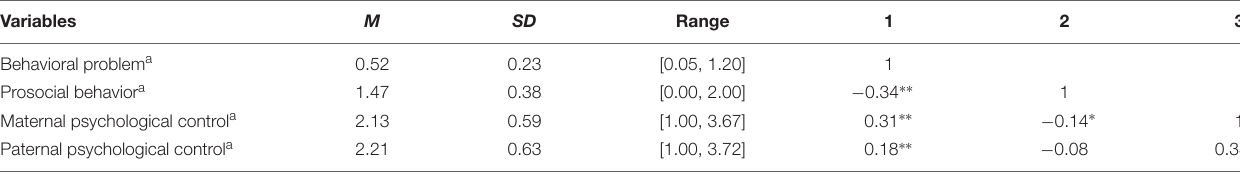
TABLE 1 | Descriptive statistics and correlations for measures constructs.